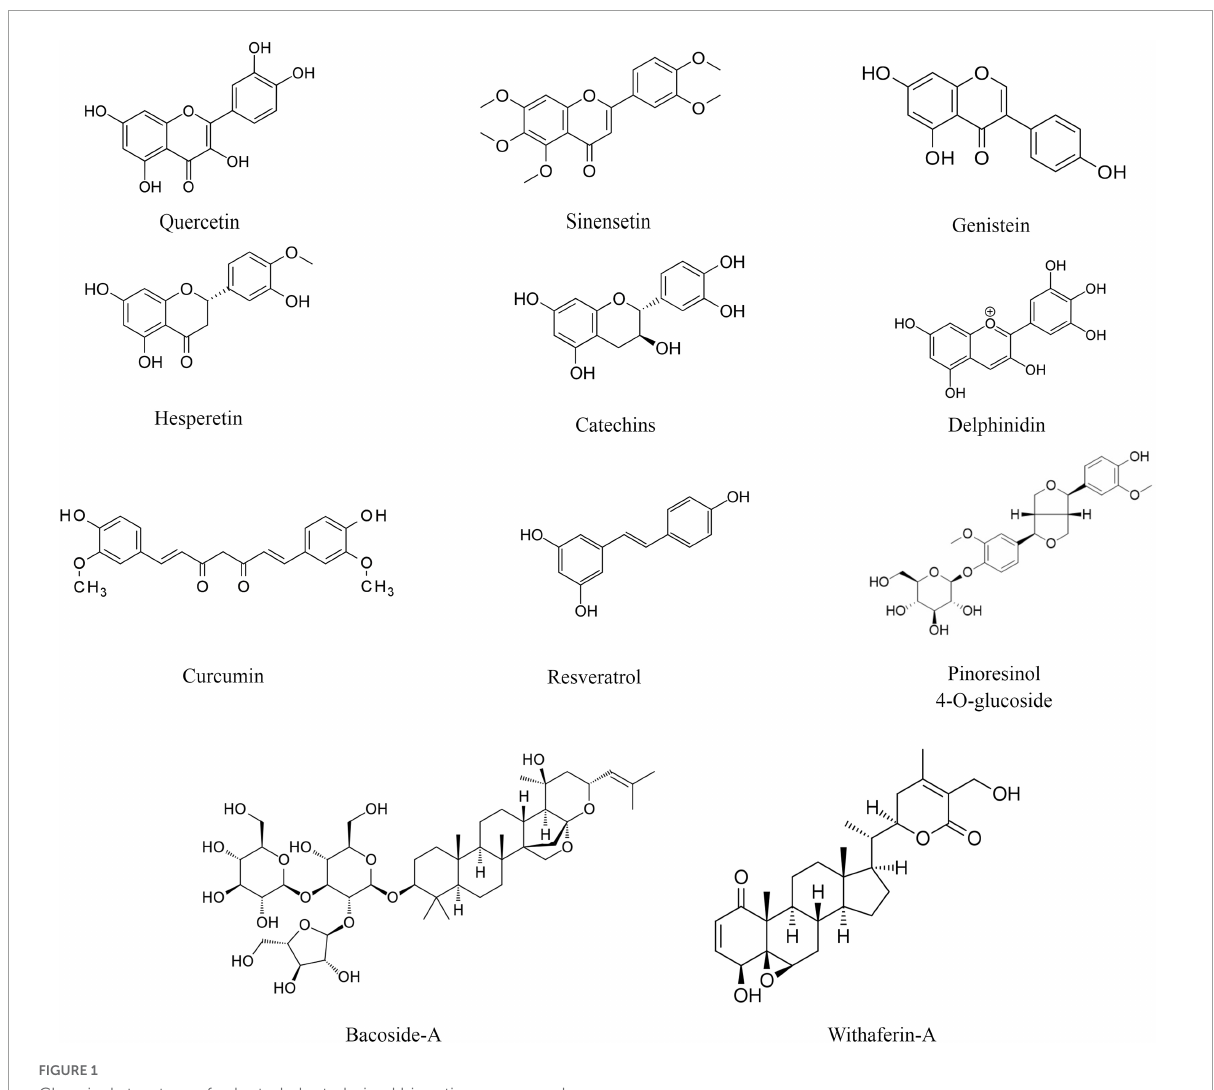
FIGURE1 Chemical structure of selected plant-derived bioactive compounds.